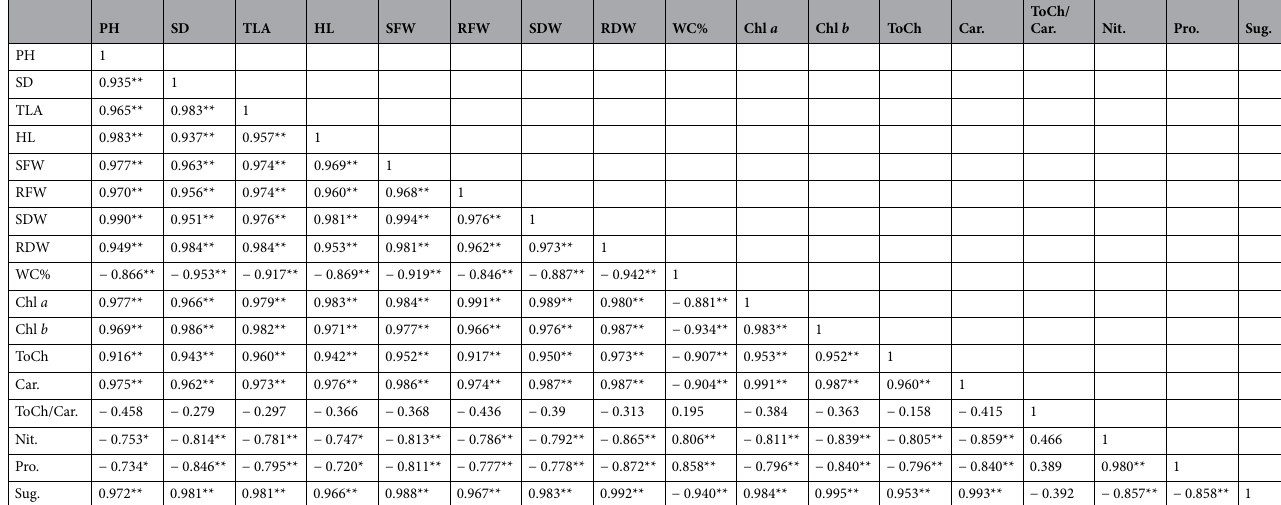
14/10 h). While the best combination of different factors with the levels for the highest soluble sugar con- tent was A ANOVA (Table 2) showed that these three factors were significant effects on biochemical traits of cucumber seedlings ( p ˂ 0.05), excepted factors C on soluble sugar content had no significant effects. Correlation analysis. Pearson’s correlation 31 was carried out among the morphological, photosynthetic pigments content, and biochemical traits observed in this study as shown in Table 3. There was a highly signifi- cant positive correlation between PH with [(SD R 2 = 0.935), (TLA R 2 = 0.965), (HL R 2 = 0.983), (SFW R 2 = 0.977), (RFW R 2 = 0.970), (SDW R 2 = 0.990), (RDW R 2 = 0.949), (Chl a R 2 = 0.977), (Chl b R 2 = 0.969), (ToCh R 2 = 0.916), (Car. R 2 = 0.975), and (Sug. R 2 = 0.972)]. While the correlation relation between PH with (WC%, ToCh/Car., Nit., and Pro.) were found significantly negative (R 2 = − 0.866, − 0.458, − 0.753, and − 0.734, respectively). Addition- ally, a positive significant relationship was found between SD and [(TLA R 2 = 0.983), (HL R 2 = 0.937), (SFW R 2 = 0.963), (RFW R 2 = 0.956), (SDW R 2 = 0.951), (RDW R 2 = 0.984), (Chl a R 2 = 0.966), (Chl b R 2 = 0.986), (ToCh R 2 = 0.943), (Car. R 2 = 0.962), and (Sug. R 2 = 0.981)]. Whereas the negative correlations were found between SD and WC %, Nit., and Pro. (R 2 = − 0.953, − 0.814, and − 0.846, respectively). The relationship between Nit. and Pro. with all morphological traits was high significantly negative, while the relationship between Sug. and all morphological traits was high significantly positive as shown in Table 3. Discussion For proper growth and development, plants are grown under constantly changing light conditions. Some light wavelengths are critical for plant growth and development. Plants are observed to detect subtle changes in light quality by light receptors. These light receptors can initiate signal transduction through various pathways to alter plant appearance 32–34 . It has been observed that photosynthetically active radiation (PAR; 400–700 nm) plays a direct role in photosynthetic processes of plants. Red light in the range of 610–700 nm and blue at 425–490 nm is the optimal light spectrum for photosynthesis in plants 35 . Recently, there are many research results that focused on the effects of LED light on morphogenesis and photosynthesis. They observed that red and blue light improved plant production when light irradiance and quality were controlled 36–38 . Growth parameters. The photosynthetic process in leaves requires the capture of light, which is influenced by the wavelength (light spectrum), intensity and angle of incidence 39 , and total leaf area. It was observed that cucumber seedlings responded strongly to LM9 in terms of plant height, stem diameter, total leaf area, hypocotyl length, shoot fresh weight, root fresh weight, shoot dry weight, and root dry weight (Fig. 1). This finding agreed with the results of Naznin et al. 37 and Yang et al. 40 in pepper seedlings and Yang et al. 41 in tomato seedlings, they observed that a mixture of red and blue LED light was efficient in producing strong seedlings. The combination of red and blue light was shown to be the most beneficial in promoting plant growth and development in the